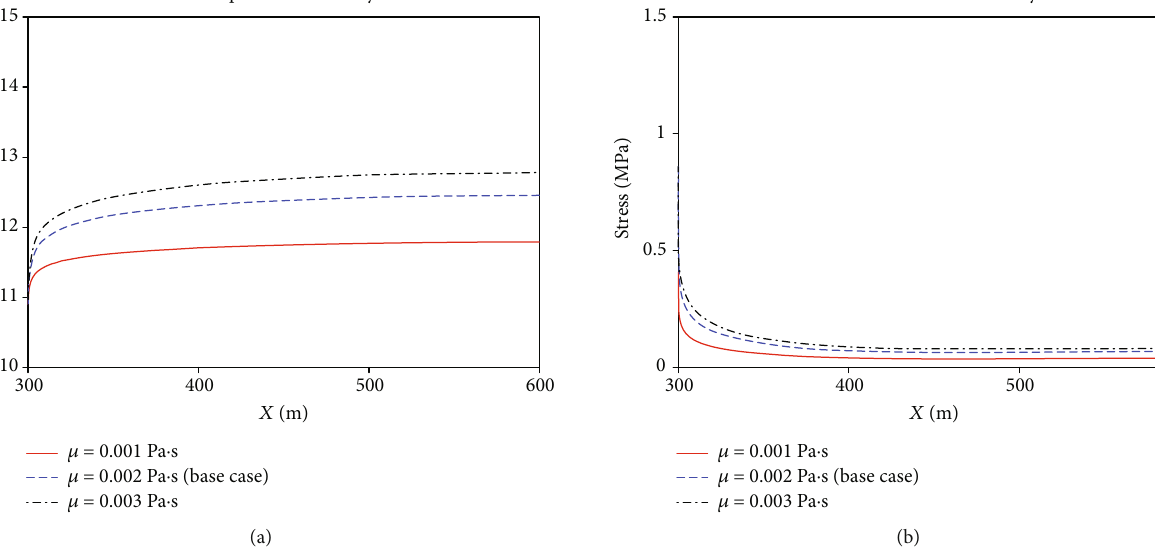
Figure 15: 1D (a) pressure and (b) stress distributions from the wellbore to the domain boundary along Y = 300m after 1 day of shallow water fl ow for viscosity